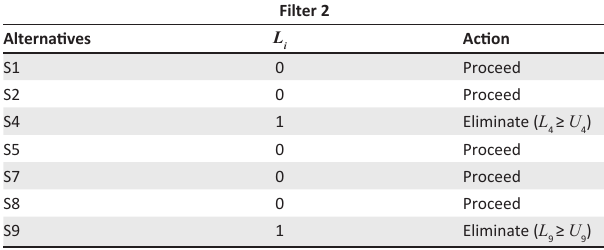
TABLE 11: Filtering step for lower